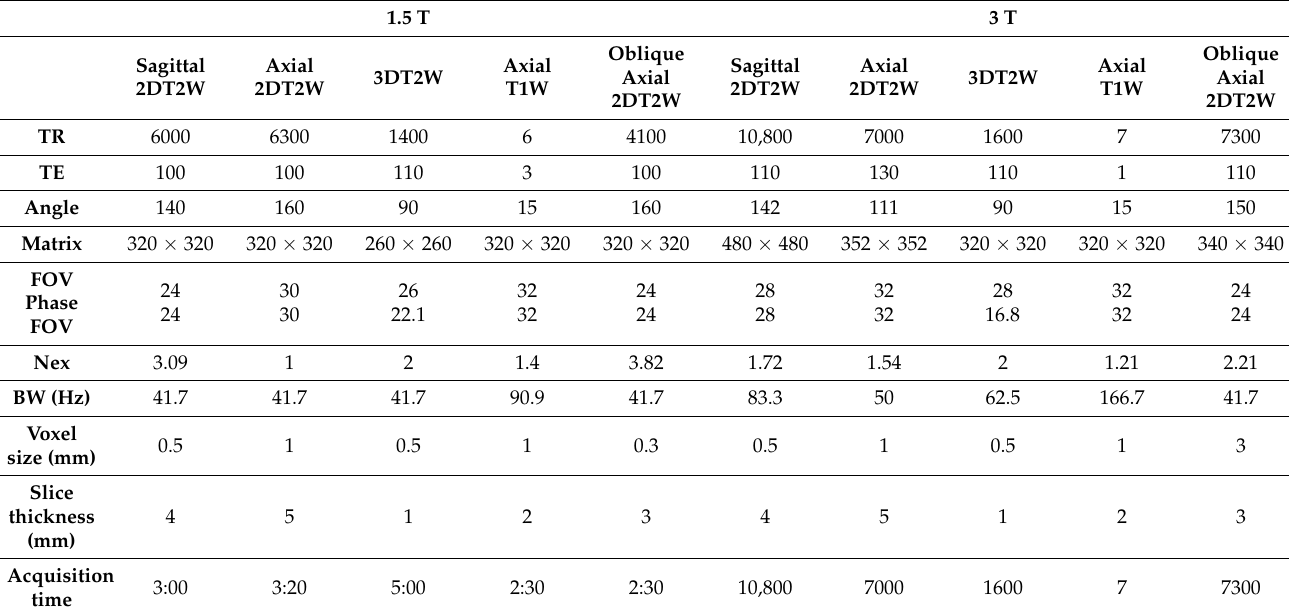
Table 1. Parameters of MRI